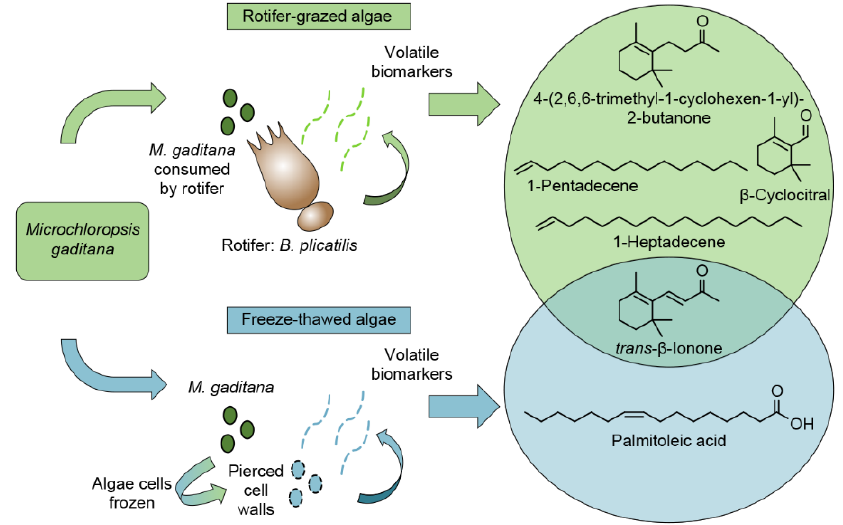
Figure 4. Resulting putative biomarkers from rotifer-grazing and freeze–thawed algal crop damage experiments to Microchloropsis gaditana cells.